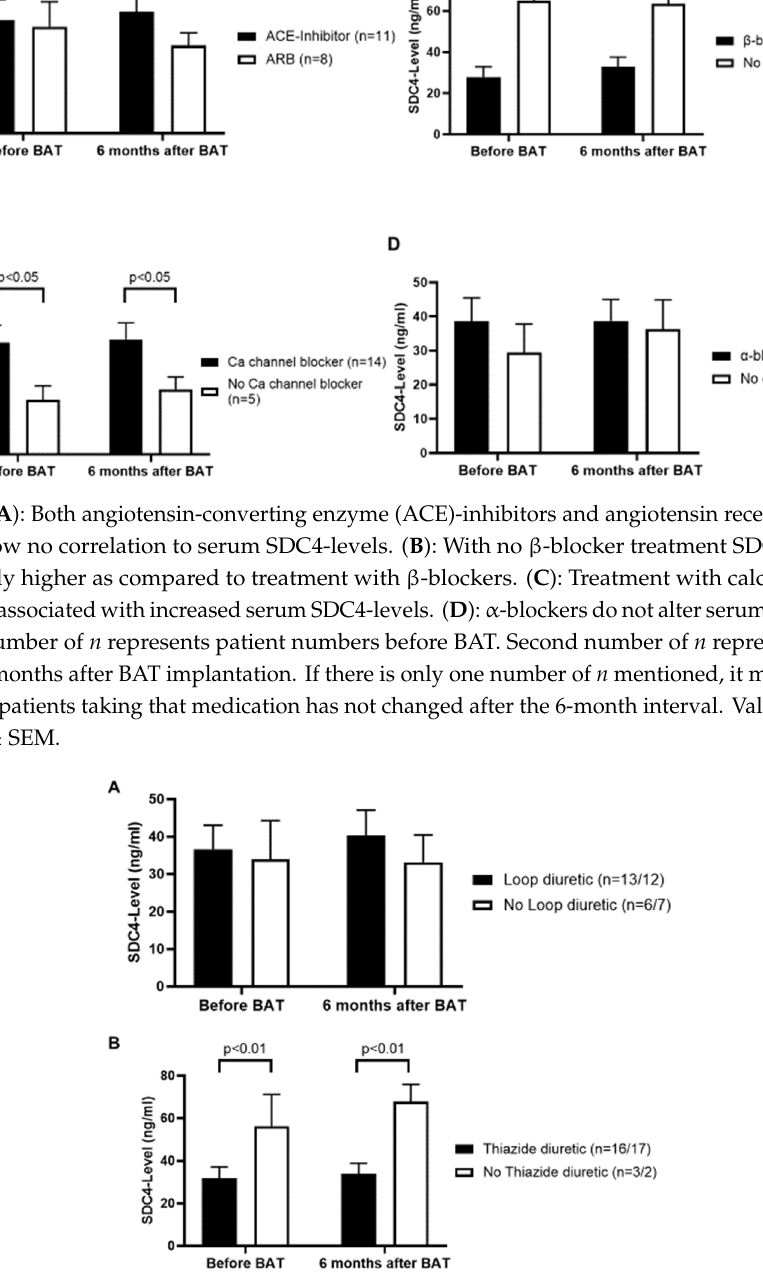
Figure 6. ( A ): Loop diuretics do not correspond to serum SDC4-levels. ( B ): Treatment with thiazide diuretics reveals lower serum SDC4-levels. The first number of n represents patient numbers before BAT. Second number of n represents patient number 6 months after BAT implantation. Values are given as means ± SEM.